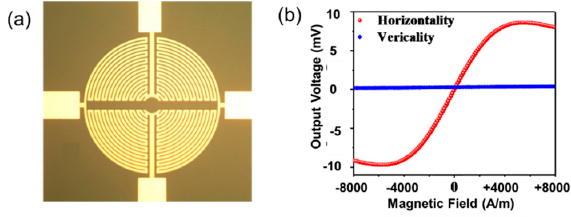
Figure 4. ( a ) A photograph of the PHR sensor and ( b ) the relation between the output voltage and the applied magnetic field with horizontality or verticality.